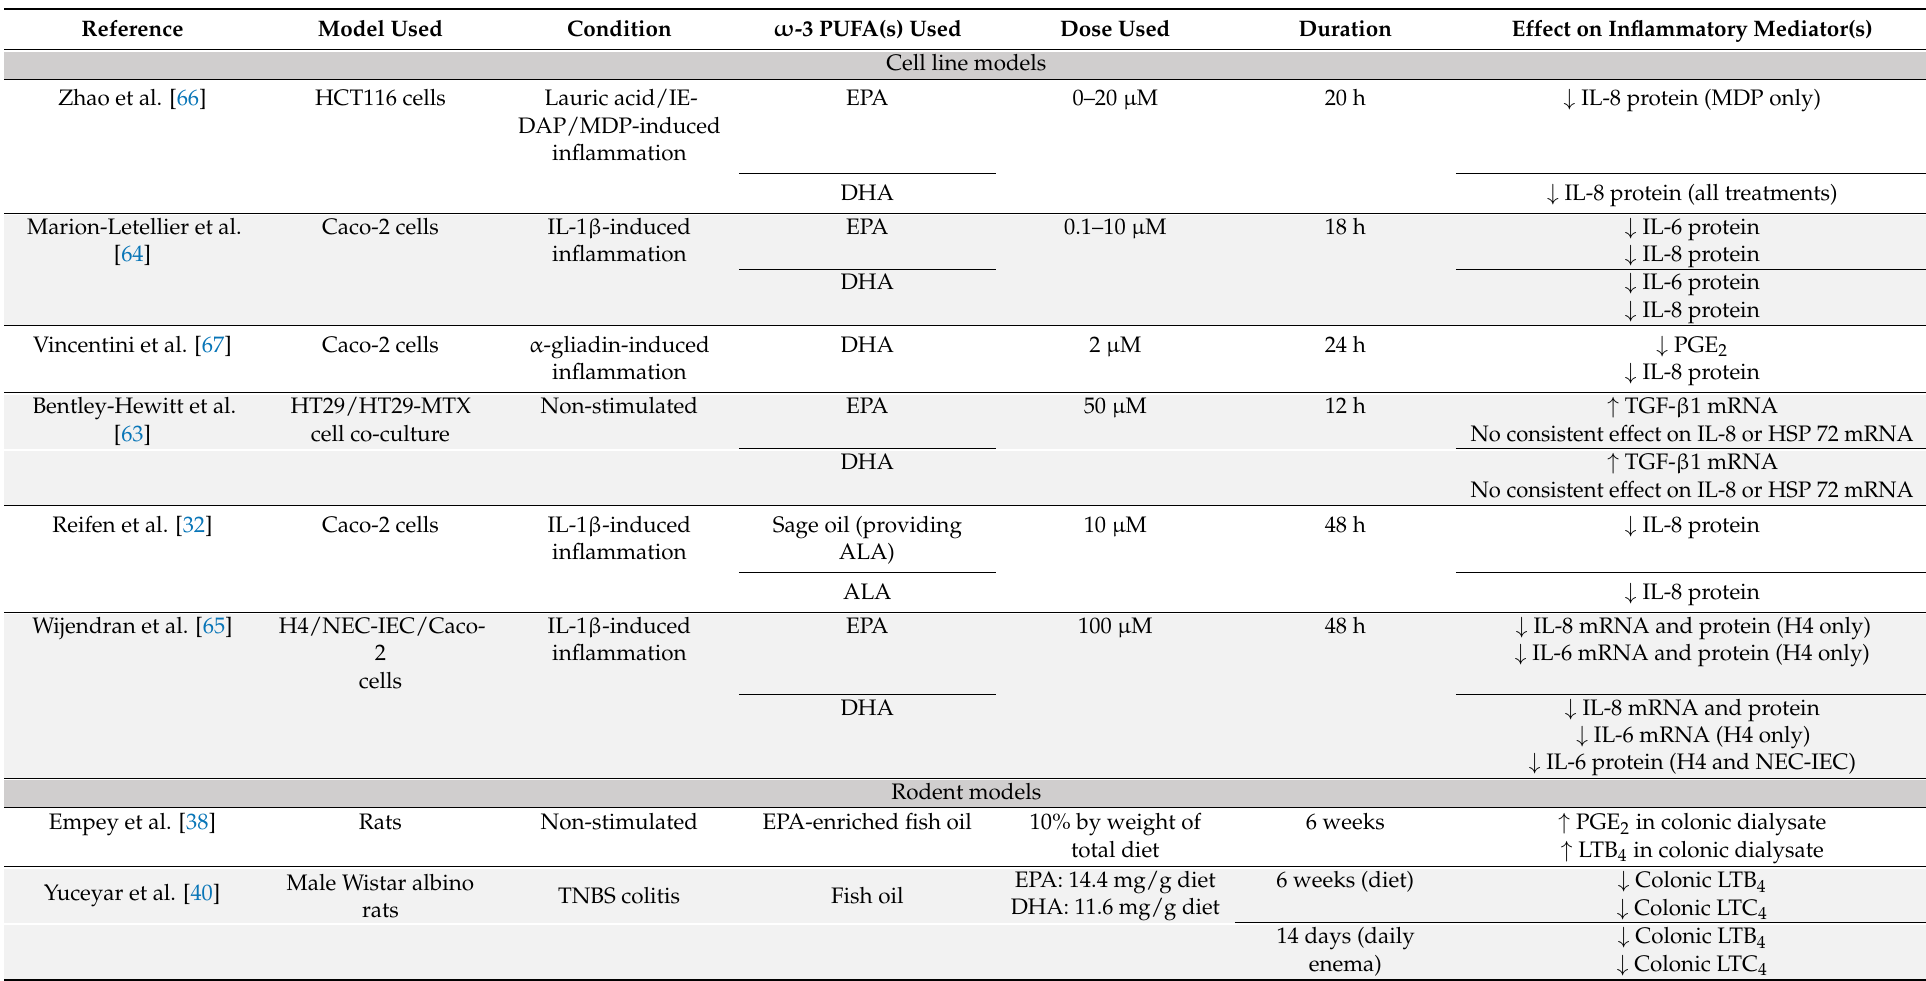
Table 5. Effects of ω -3 PUFAs on inflammatory mediators in cell, rodent and human